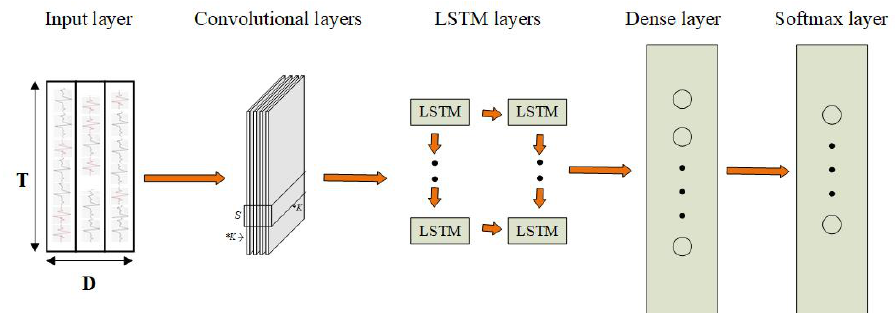
Figure 5. Architecture of a hybrid for human activity recognition. T in the input layer denotes the length of the time window. D denotes the number of sensor channels. In convolutional layers, K denotes the kernels in layers, and S is the length of kernels. The convolutional layers can extract features from input data and provide abstract presentations of data in feature maps. LSTM layers learn temporal dynamics from